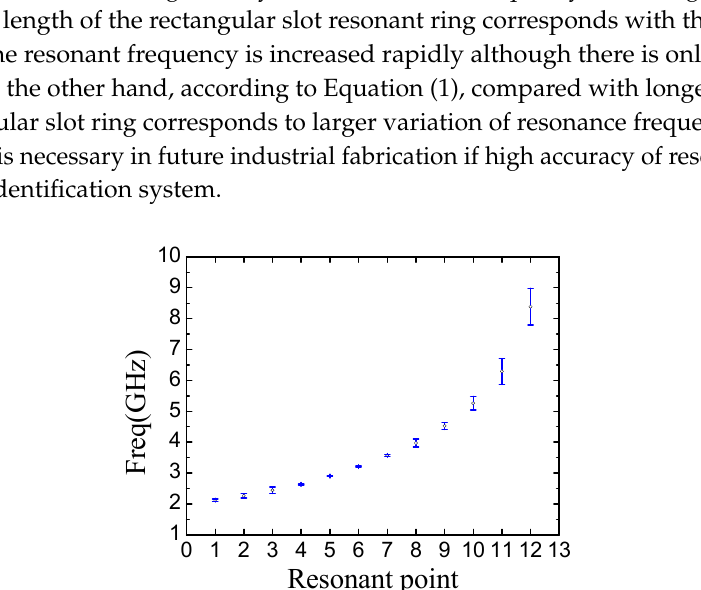
Table 3. The Comparison between Costa’s and this work.